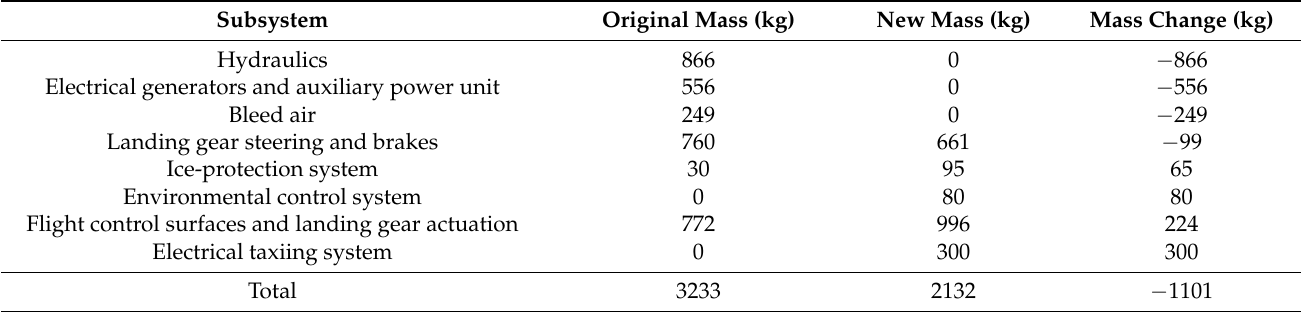
Table A1. More-electric aircraft subsystem mass savings (adapted from [66,91,92]).